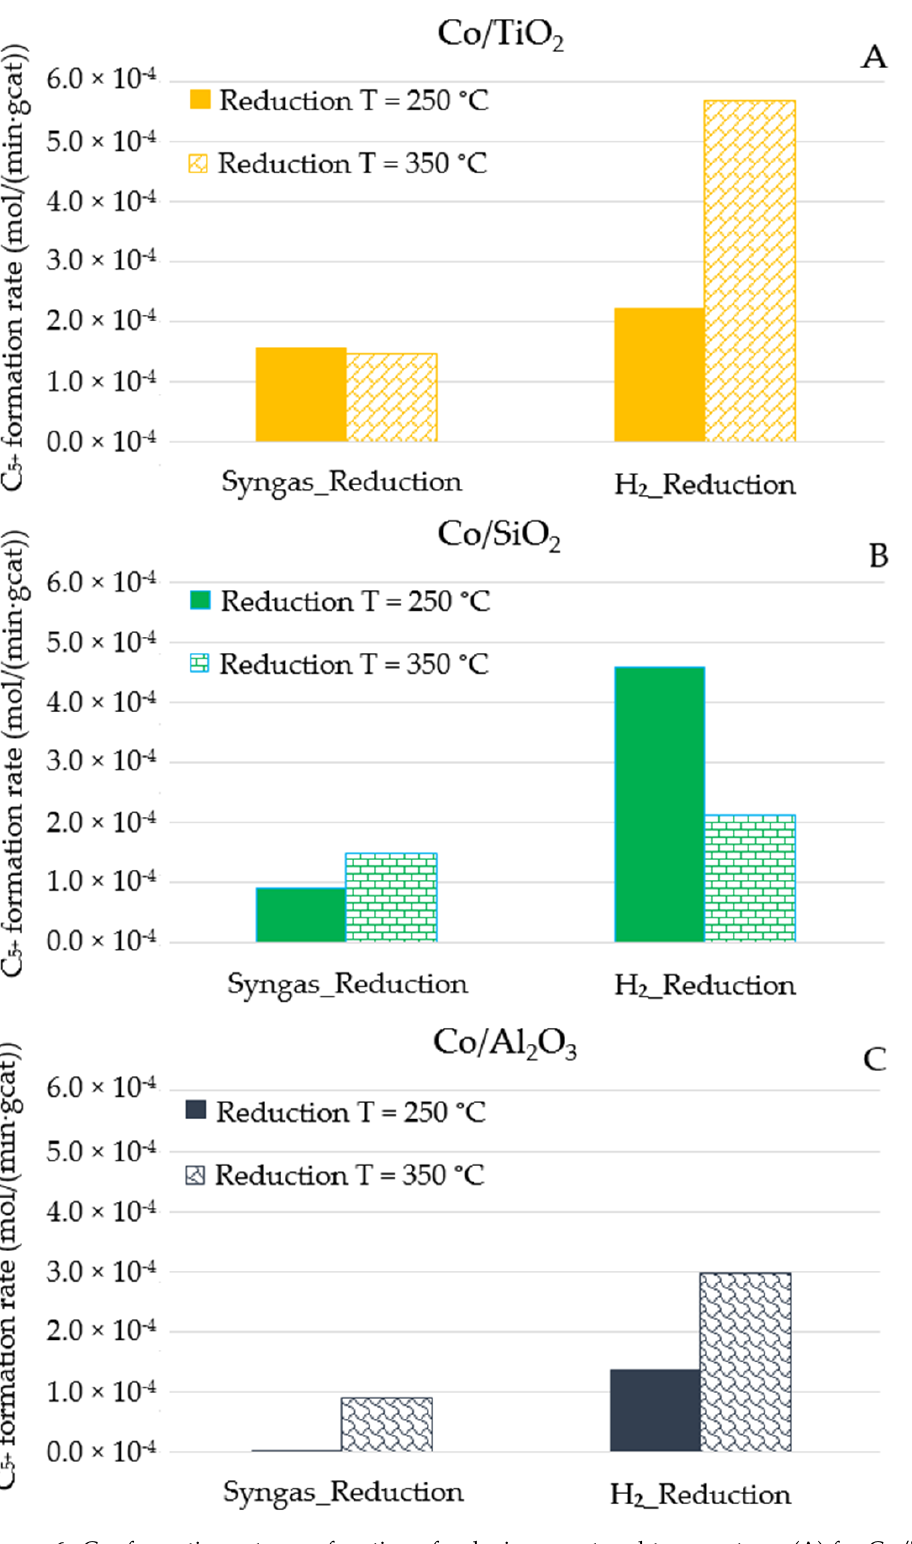
Figure 6. C 5+ formation rate as a function of reducing agent and temperature: ( A ) for Co/TiO 2 , ( B ) for Co/SiO 2 , and ( C ) for Co/Al 2 O 3 . Reaction conditions: 20 bar, 60 mL/min, and 210 °C.